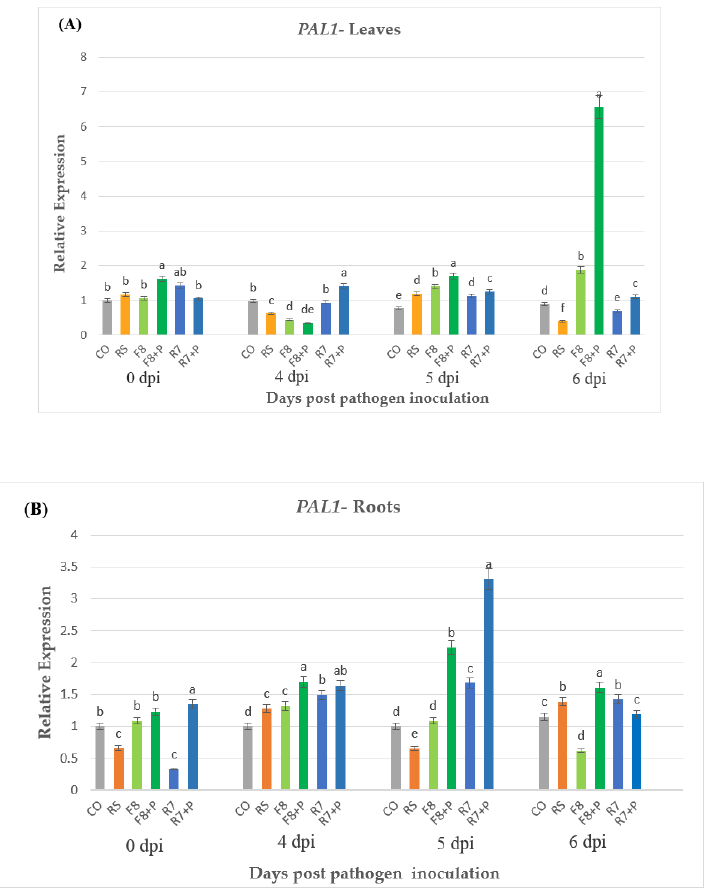
Figure 9. Effects of Streptomyces strains on PAL1 gene expression. ( A , B ) PAL1 expression changes in tomato leaves and roots, respectively, at different time points in plants inoculated with R. solani AG4. Statistically, values of each column indicated by the same letters (a-d) have no significant dif- ferences according to LSD test ( p ≤ 0.05). CO: Control treatment without pathogen and Streptomyces ; RS: Rhizoctonia solani (pathogen); F8: Streptomyces globisporus strain F8; F8 + P: S. globisporus strain F8 + Pathogen; R7: Streptomyces praecox strain R7 and R7 + P: S. praecox strain R7 + Pathogen. Dpi: day post inoculation with the pathogen; 0 dpi implies the first hours of pathogen infection. 4. Discussion Naturally, plants live with a diversity of microorganisms in the rhizosphere and the phyllosphere. In addition to deleterious interactions where plants deploy their immune system to withstand against pathogens and insects’ herbivores, they also establish mutu- alistic associations with beneficial microbes to improve the plants growth or to assist them in overcoming stress [62]. Thus, beneficial rhizobacteria can enhance plants immunity against pathogens by stimulating the systemic defense pathways including salicylic acid (SA) and jasmonic acid/ethylene (JA/ET) dependent signaling pathways [63,64]. The pre- sent study demonstrated that S. globisporus and S. praecox are able to enhance the expres- sion of plant defense genes encoding enzymes such as phenylalanine ammonia lyase (PAL) and lipooxygenase (LOX) in tomato seedlings. PAL is one of the most studied en- zymes in plant defense responses against biotic and abiotic stresses [65]. PAL is a key